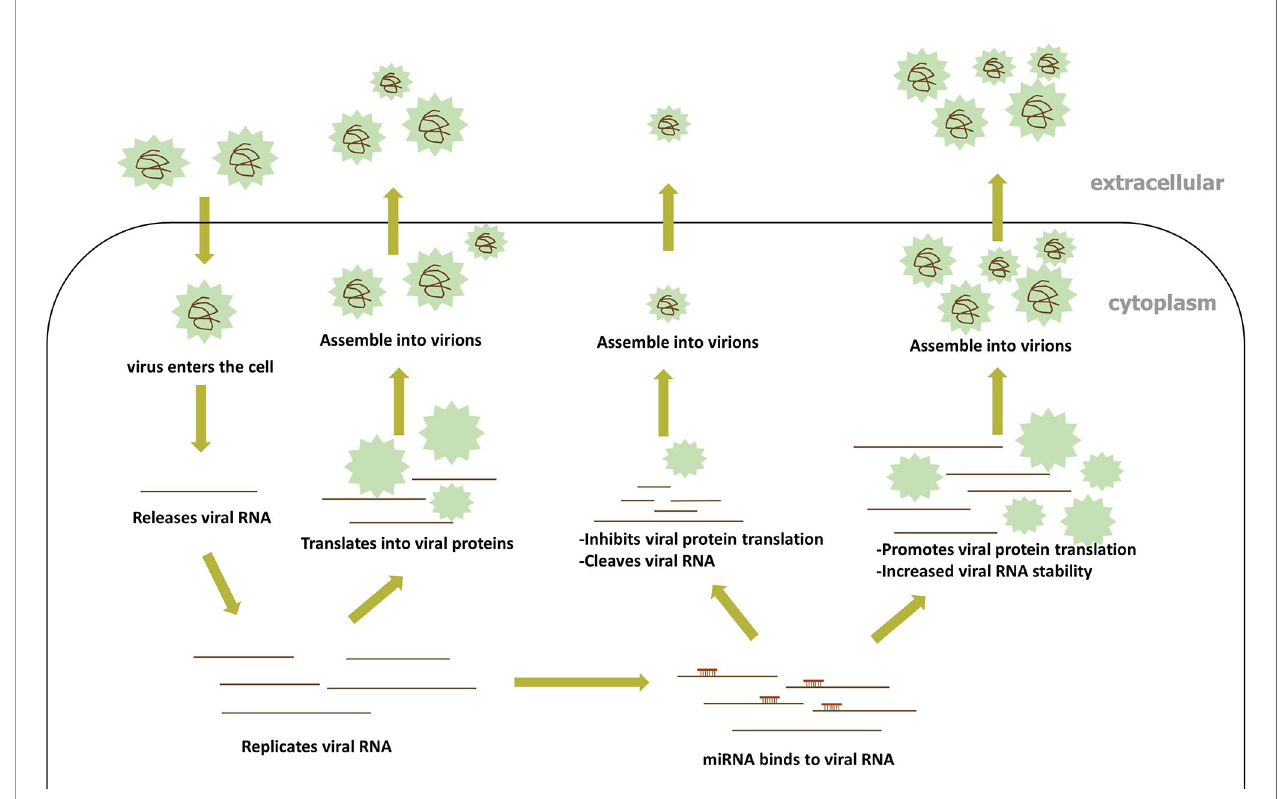
FIGURE 3 | The process of miRNA directly binding to viral